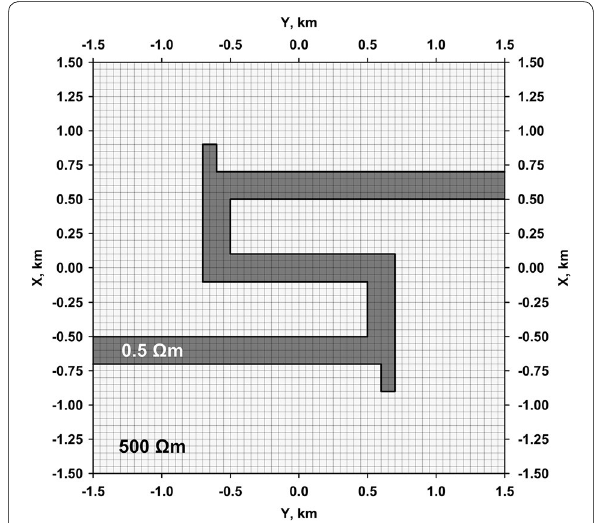
Fig. 11 Horizontal slice (z 100 m) of the SL-shaped = conductor model. Grid lines delineate the cell